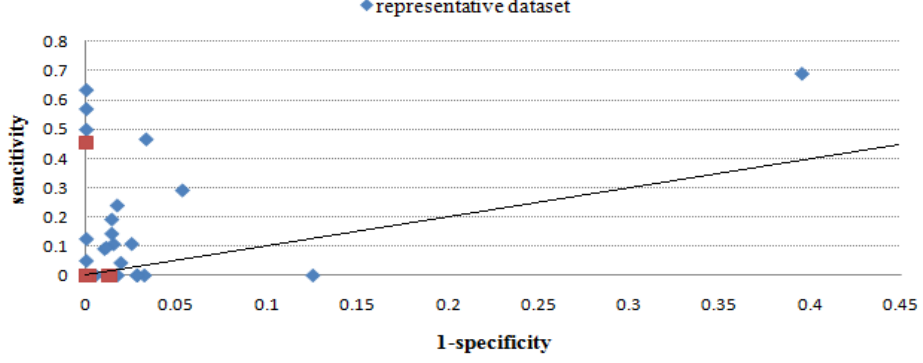
Figure 5. Sensitivity vs. 1-specificity scores of Pep-3D-Search on the benchmark dataset and the representative dataset.